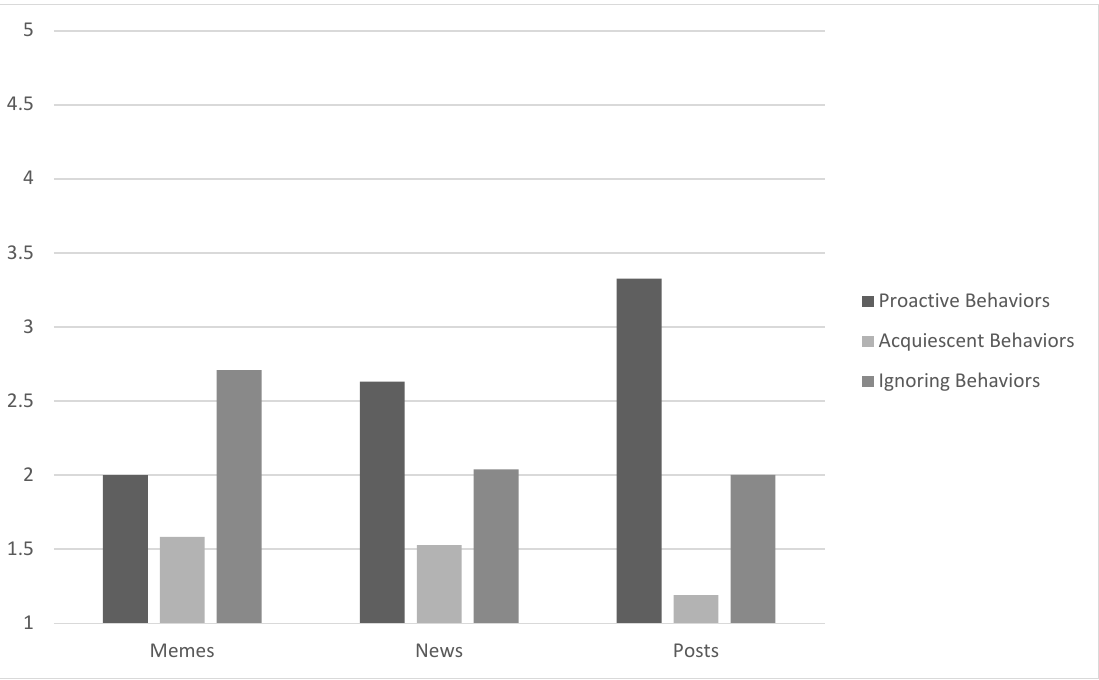
Figure 2. Differences between memes, news, and posts in terms of proactive, acquiescent, and ignoring behaviors.